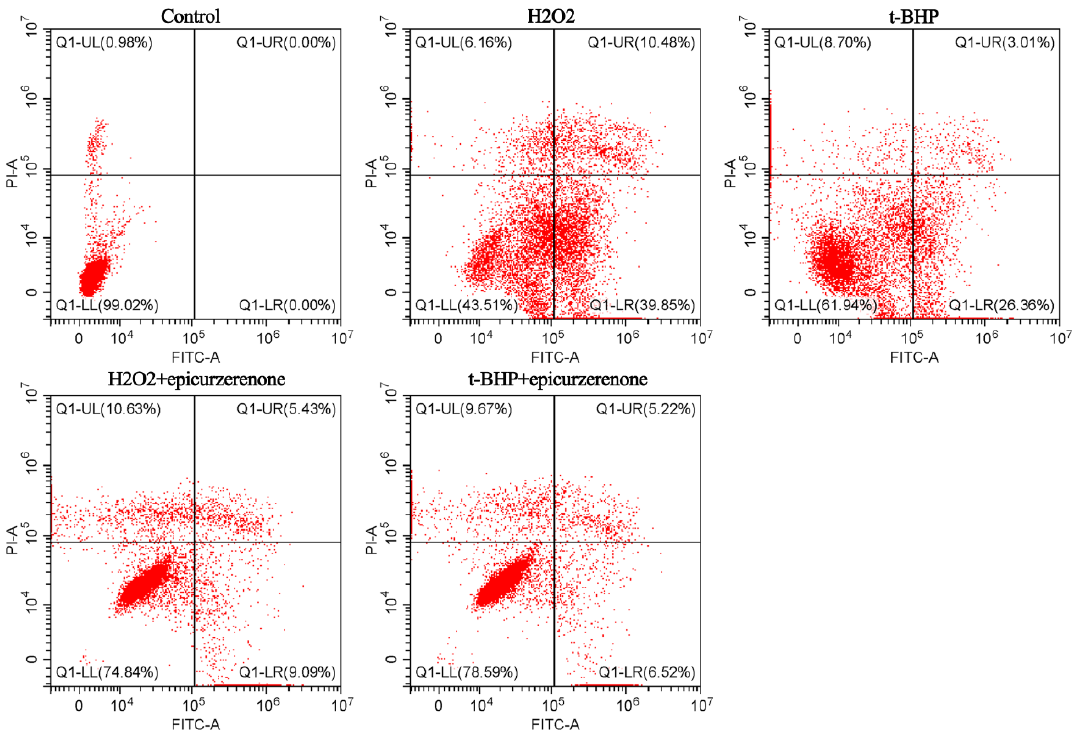
Figure 6. Epicurzerenone (32 µ M) inhibited apoptosis of L02 cells induced by 55 µ M H2O2 or 20 µ M t-BHP using Annexin V-FITC/PI staining.